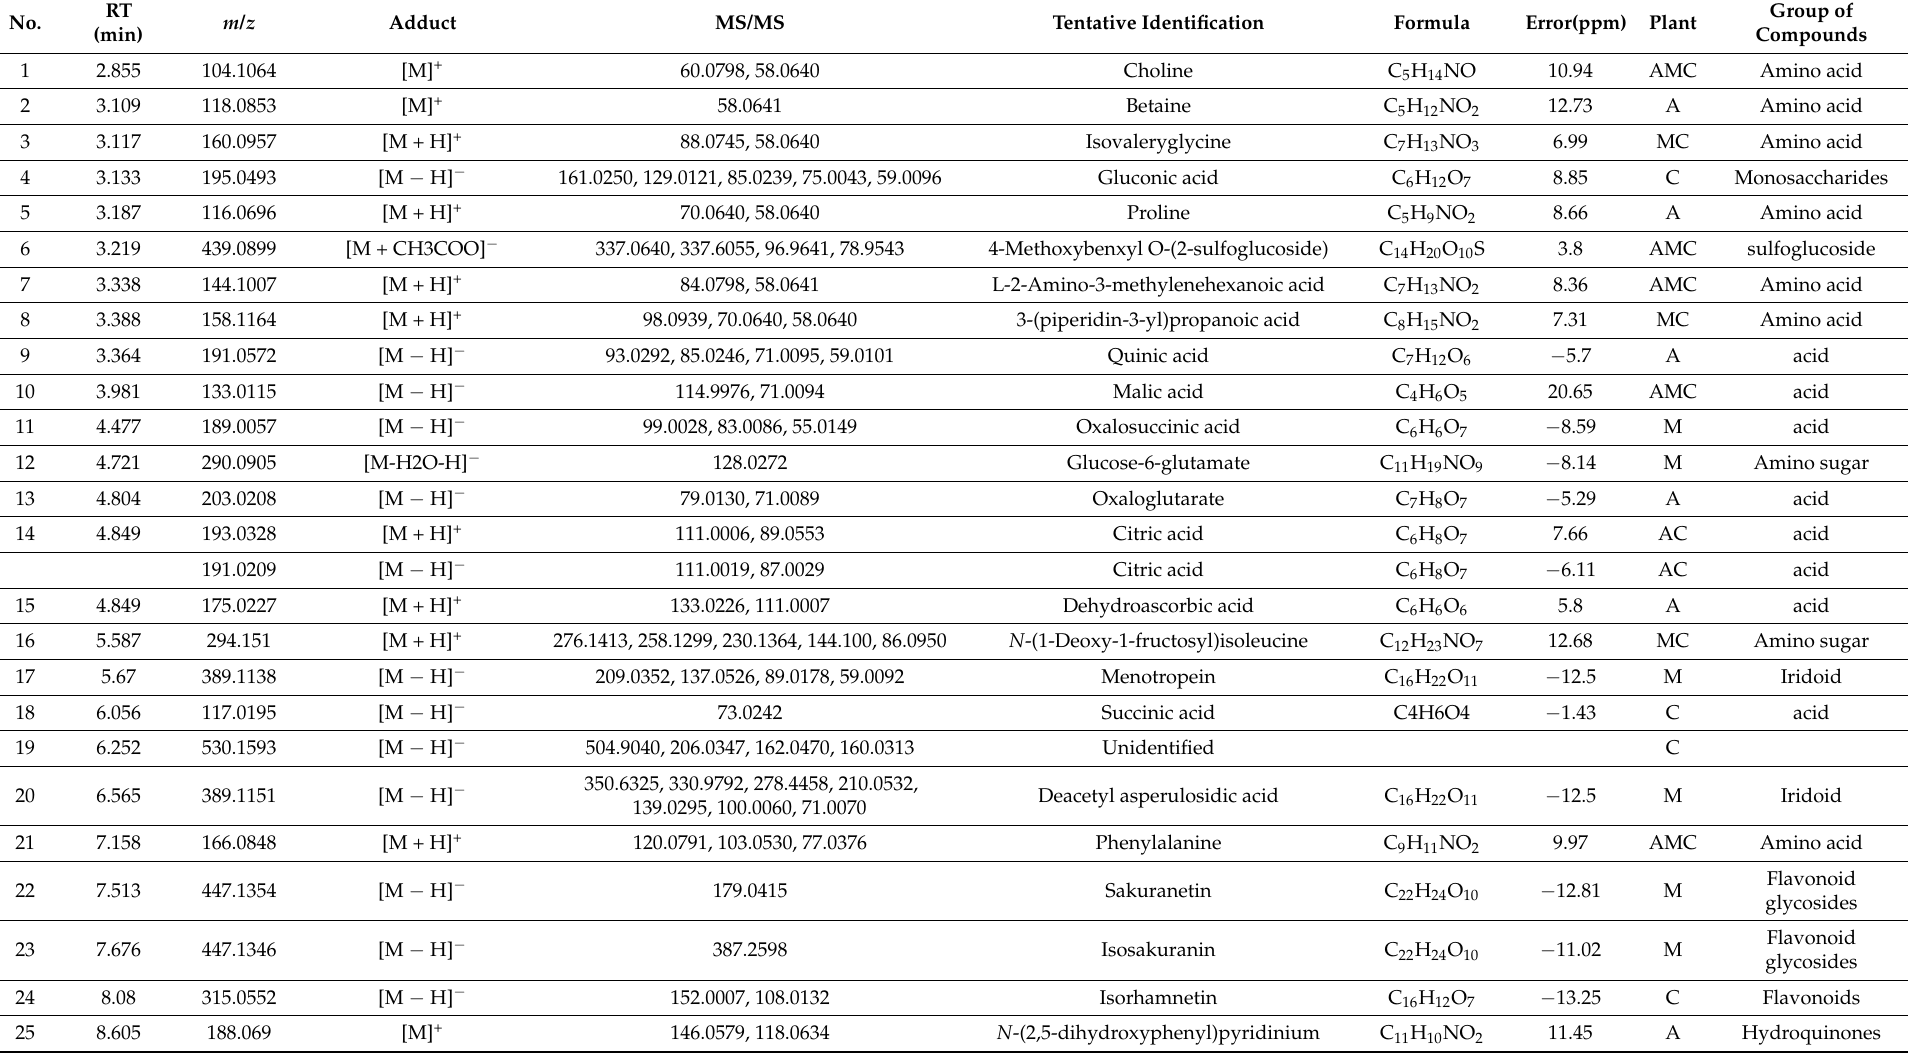
Table 3. Tentative identification of compounds found in Tri-Phon (+/ − ESI), A. marmelos (A), M. citrifolia (M), and C. sativum